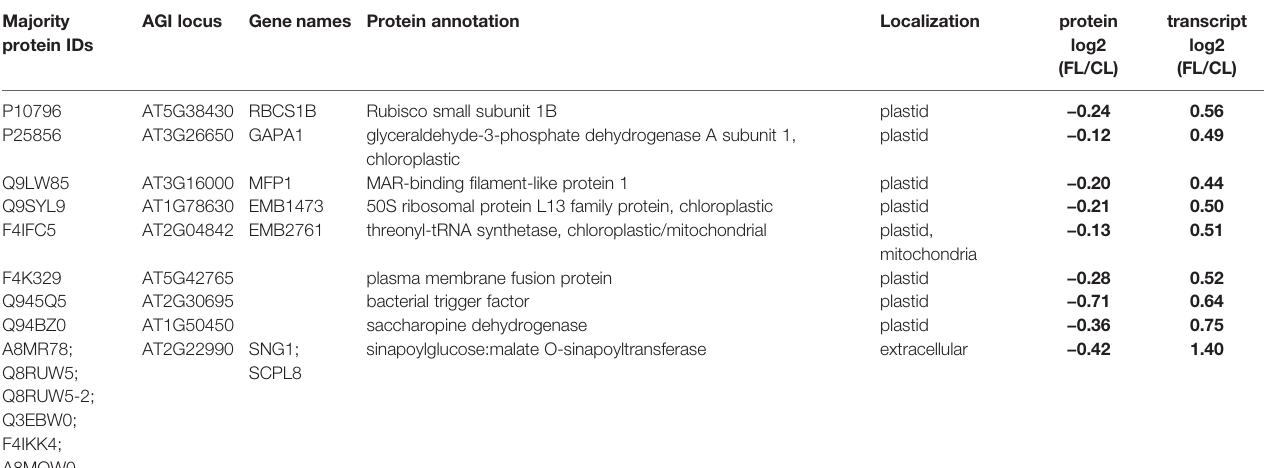
TABLE 3 | Proteins and genes with contrasting FL responses of protein and transcript abundance in mature leaves at the end of day. Localization annotation is the consensus listed in the SUBA database. Signi fi cant changes in abundance are indicated by bold letters. Majority AGI protein IDs